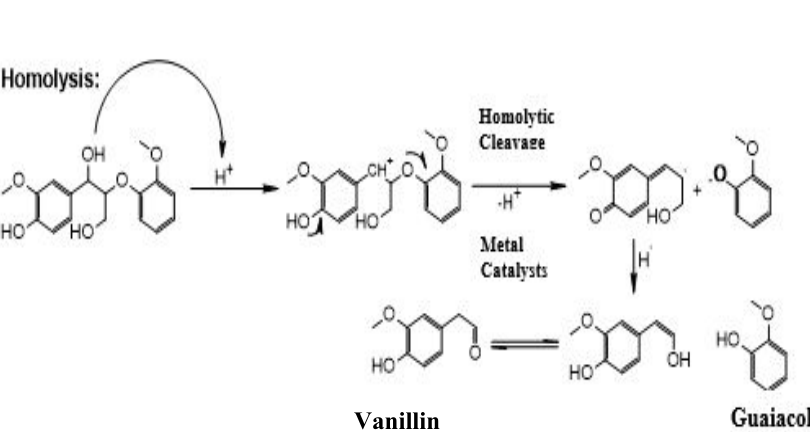
Figure 1. The possible pathways of lignin depolymerization in the presence of subcritical water and catalyst [30].